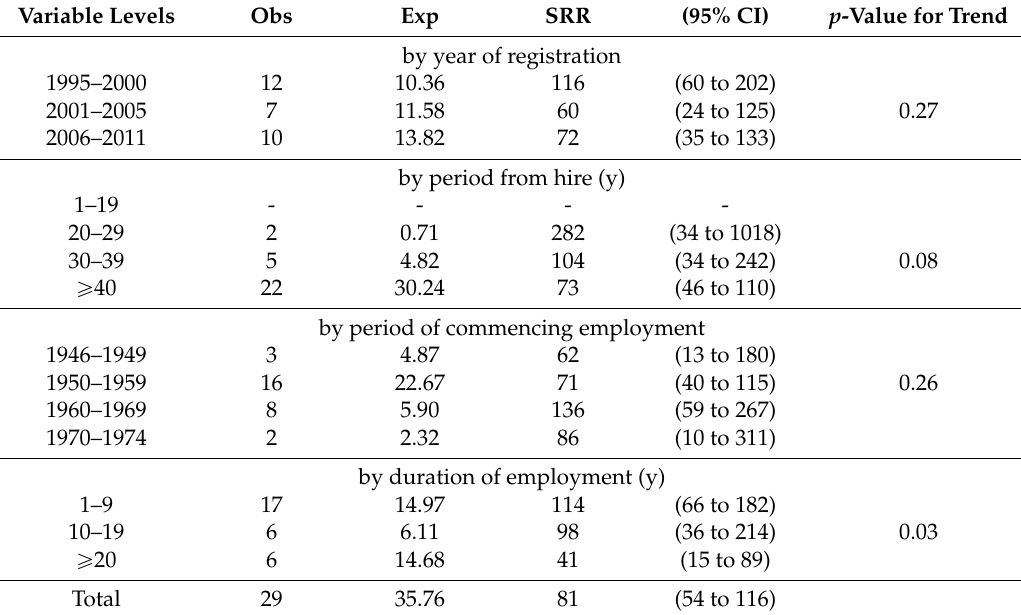
Table 3. Incidence of myelodysplastic syndrome (MDS) (ICD-10:D46) in 28,554 UK oil refinery workers, ages 15–84 years,